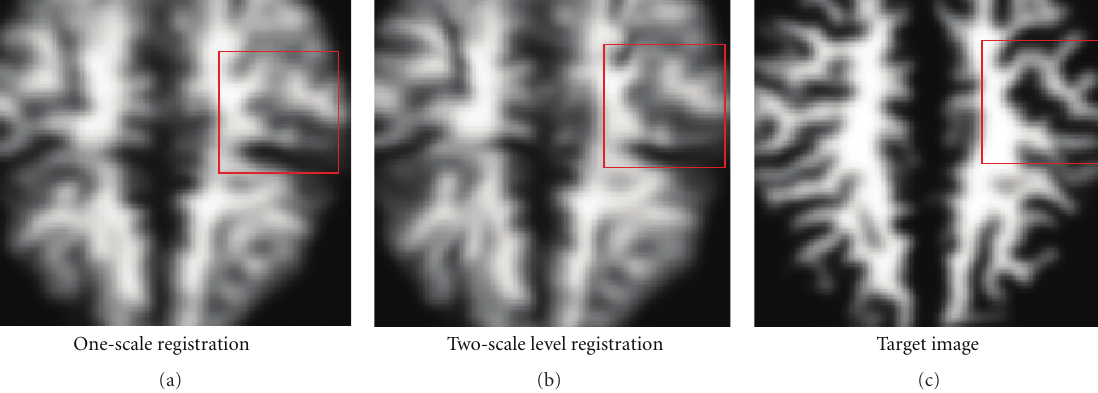
Figure 9: Multiscale registration using di ff erent sizes of computation kernels helps capture large- and small-scale changes in di ff erent levels and also increases the convergence rate of the